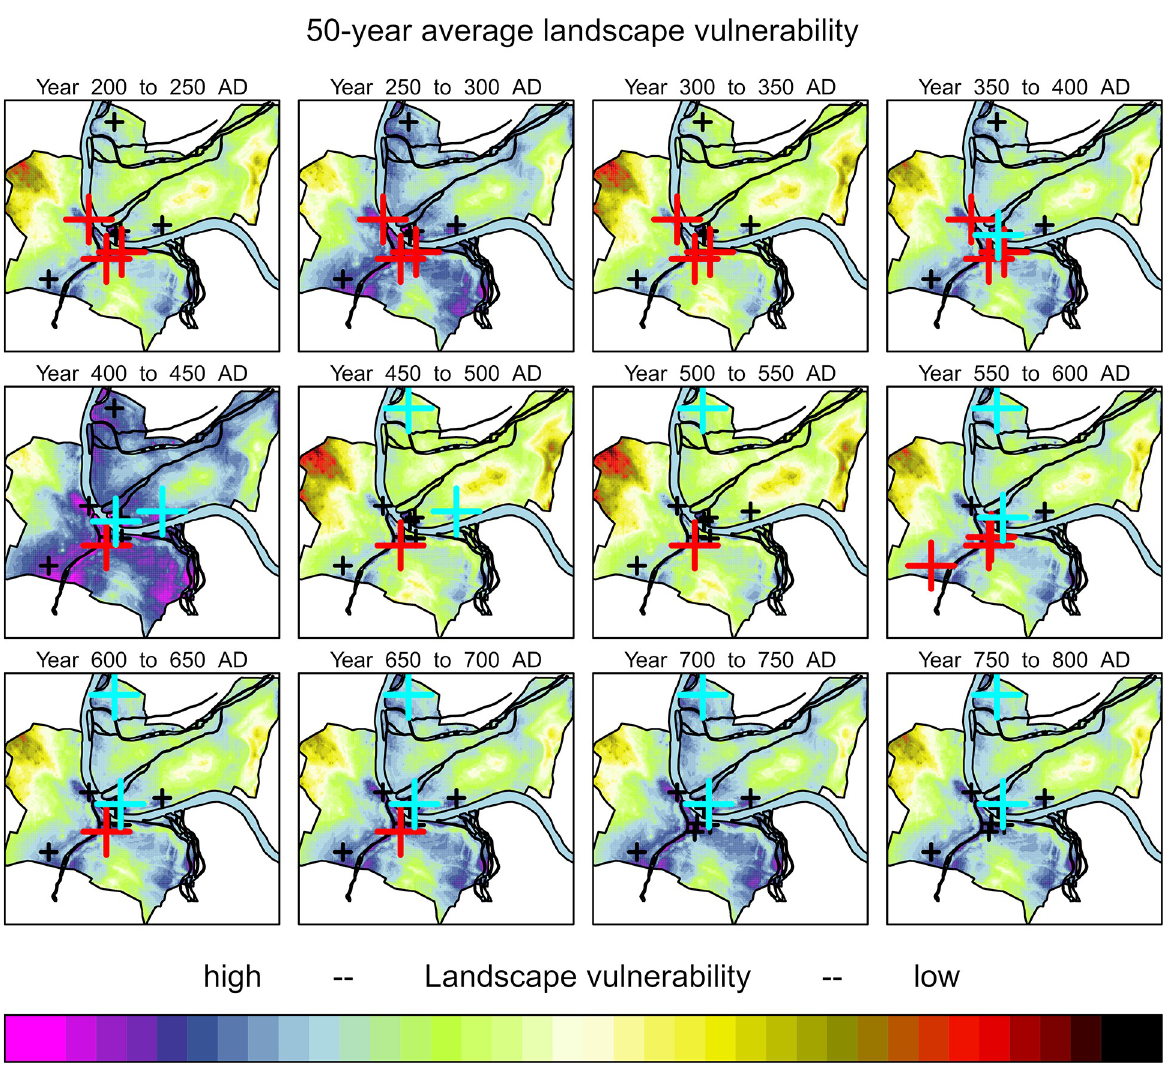
Fig 10. Model output of 50-year averages across Basel between 200 and 800 AD. Chronological occupation of the graveyards are given in red (southern bank of the river Rhine) and cyan (northern bank) (see Fig 1